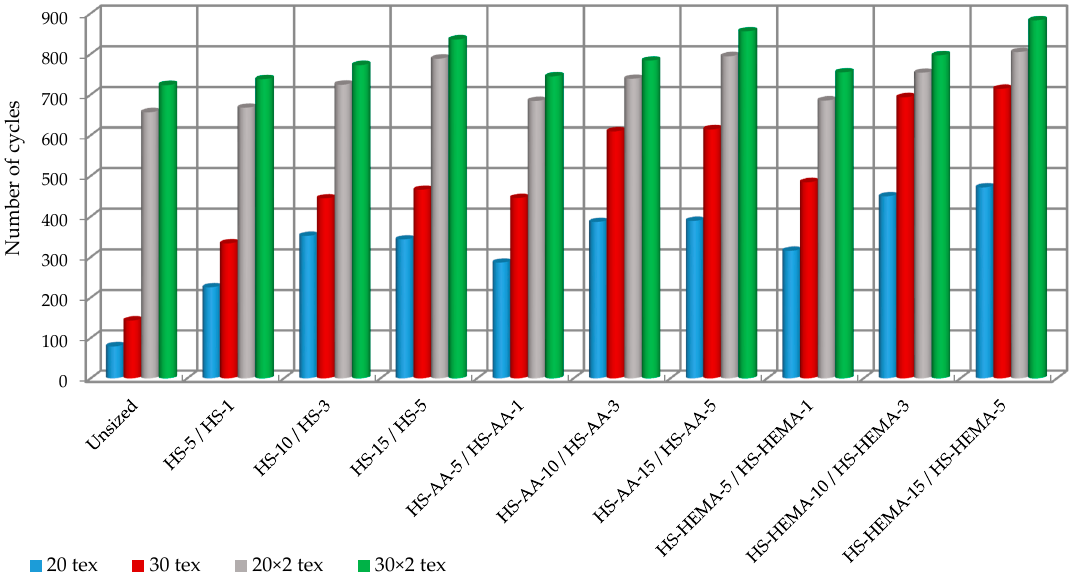
Figure 10. Yarn abrasion resistance during the sizing process.